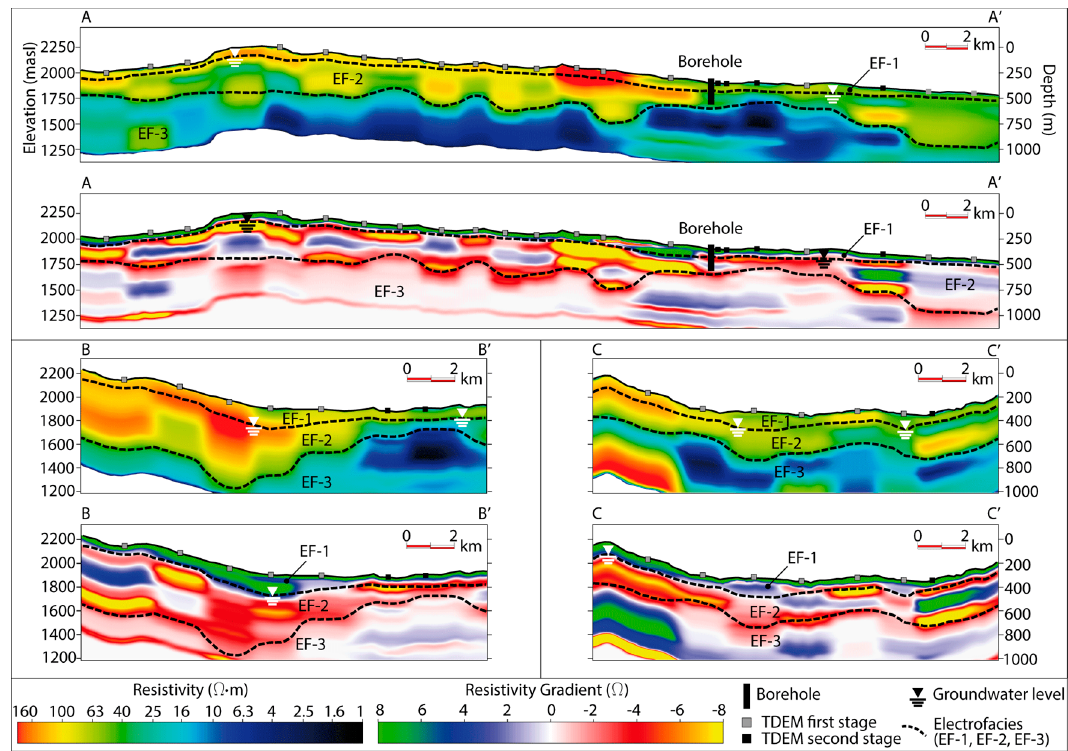
Figure 3. Subsurface hydrogeoelectrical model. EF: electrofacies. AA ′ , BB ′ and CC ′ refer to geophysical cross ‐ sections shown in Figure 2.